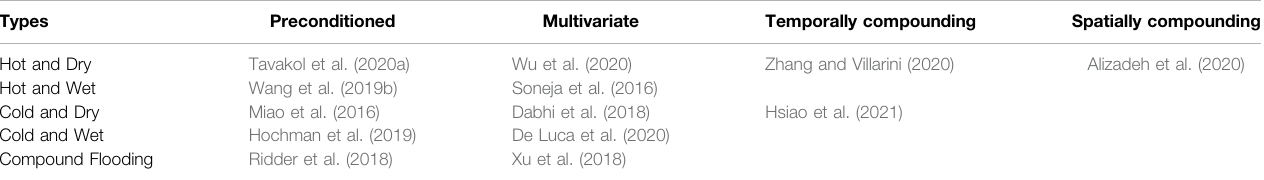
TABLE 1 | Types of compound hydrometeorological extremes under the four categories documented in (Zscheischler et al., 2020). “ X ” represents that the compound extreme type falls into a category based on literature.